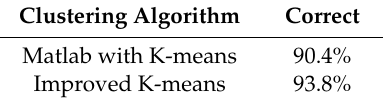
Figure 6. Improved K-means clustering. Table 10. Comparison results of Matlab’s own K-means and the improved K-means clustering.